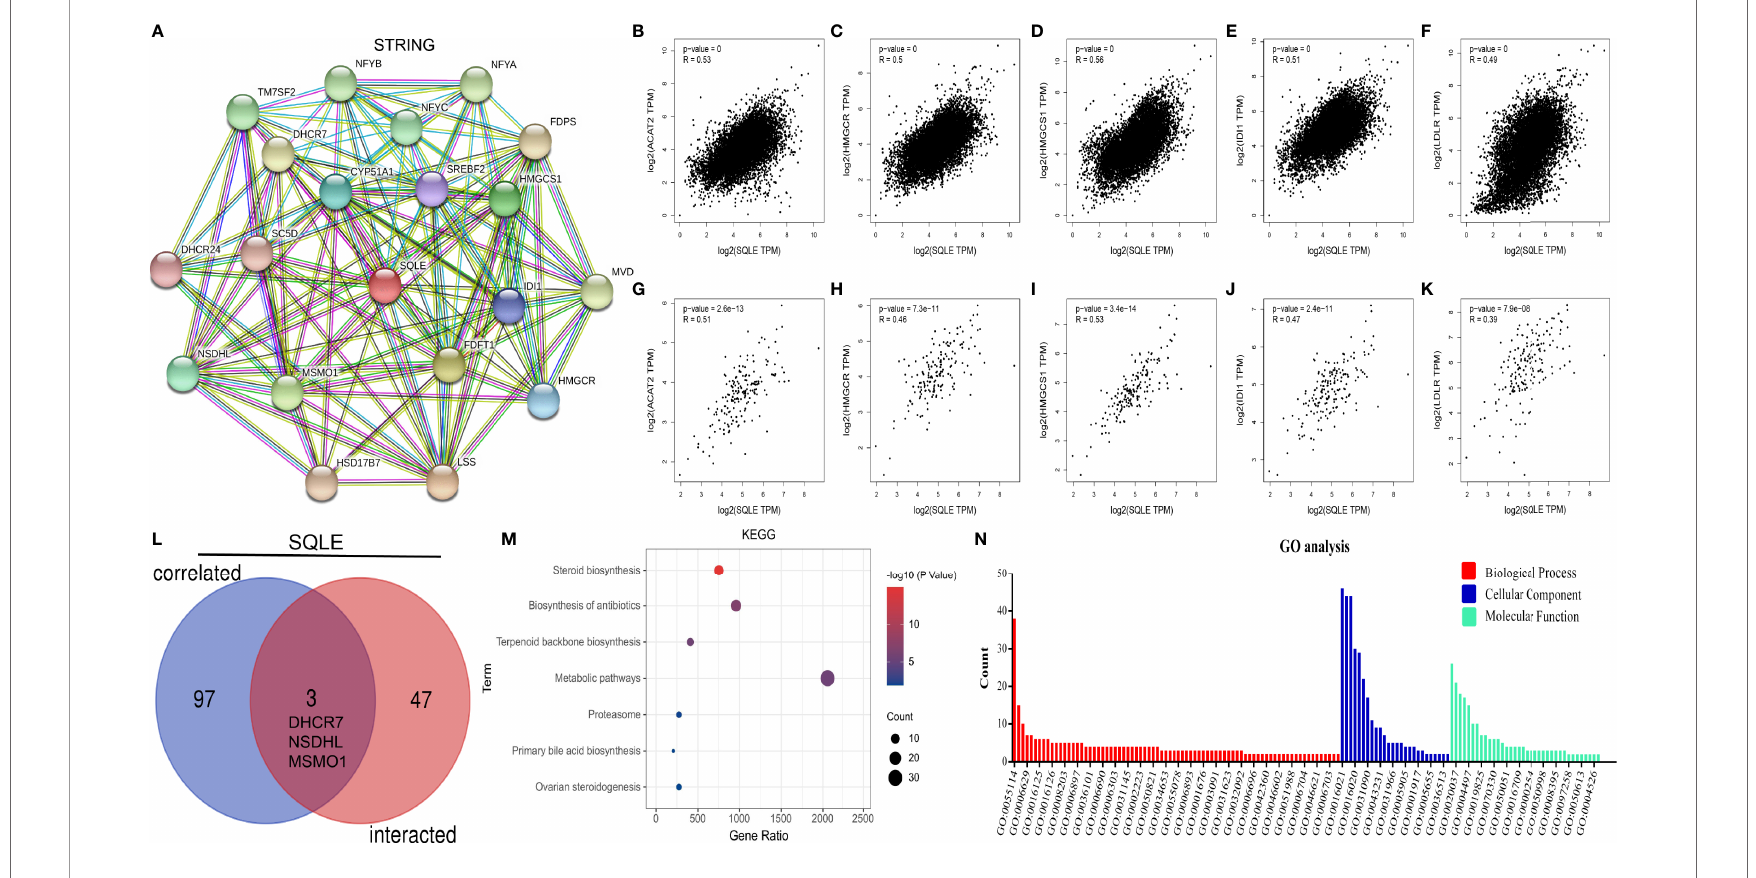
FIGURE 7 | SQLE-related gene enrichment analysis. (A) The top 20 SQLE-binding proteins using the STRING tool. (B – F) The expression correlation between SQLE and the targeting genes ACAT2 (B) , HMGCR (C) , HMGCS1 (D) , IDI1 (E) , and LDLR (F) in human cancers. (G – K) The expression correlation between SQLE and the targeting genes ACAT2 (G) , HMGCR (H) , HMGCS1 (I) , IDI1 (J) , and LDLR (K) in PAAD. (L) Interaction analysis of the SQLE-binding and related genes. (M) KEGG pathway analysis of the SQLE-binding and interacting genes. (N) GO analysis for the molecular function of the SQLE- binding and interacting